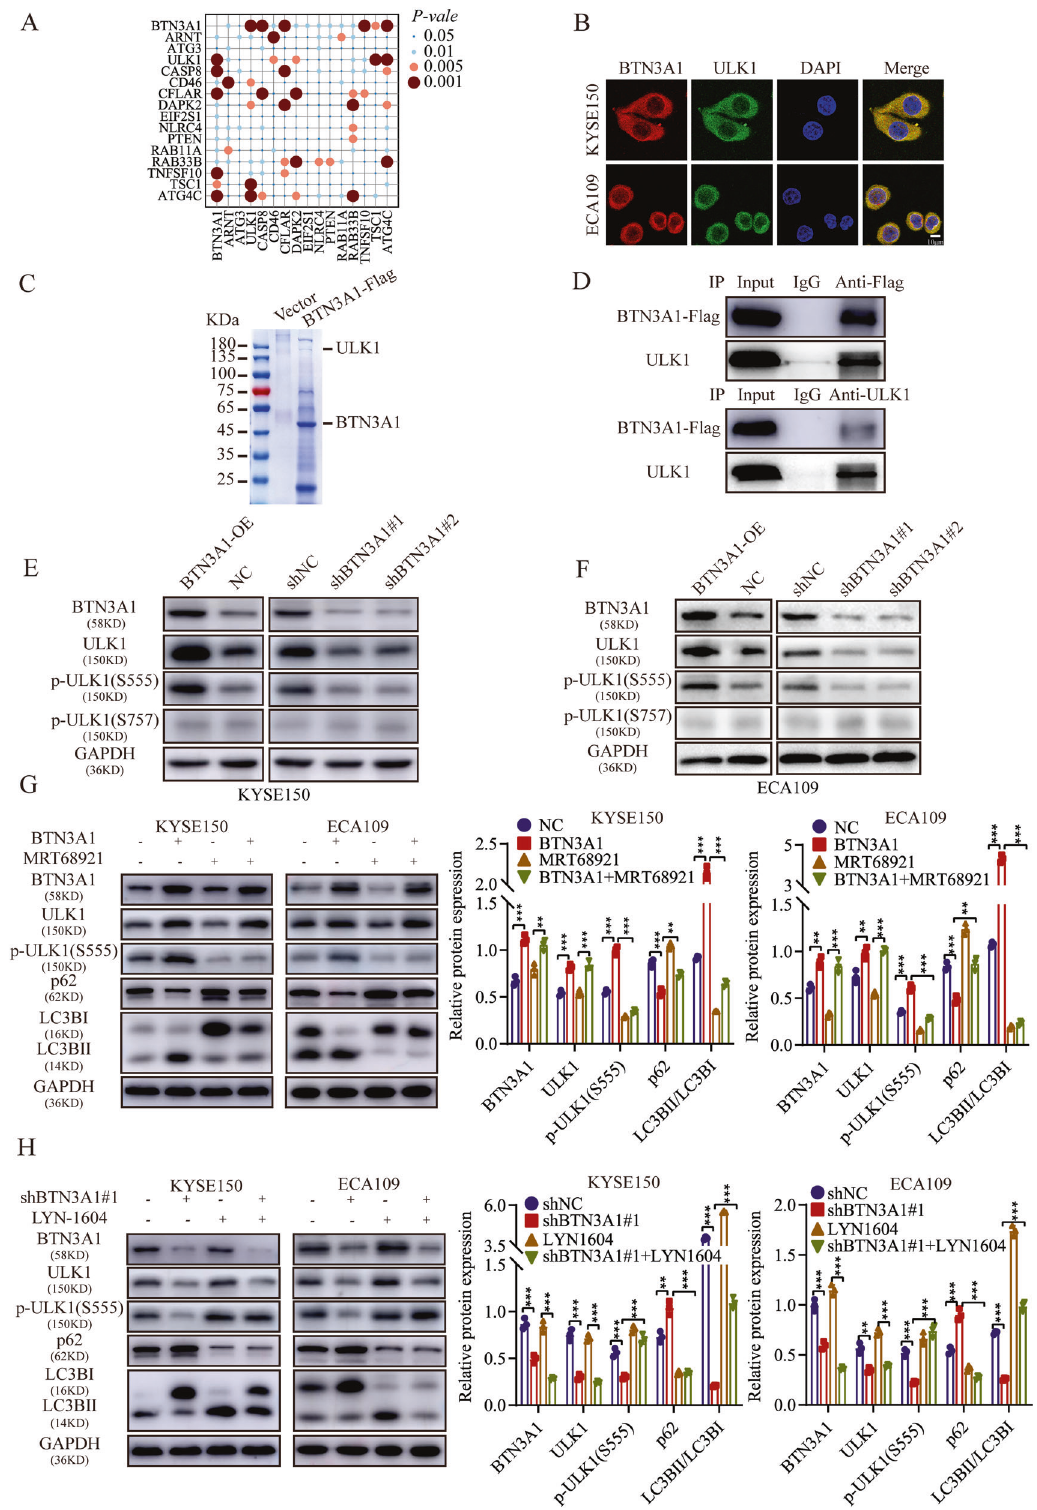
Immuno fl uorescence Cells were fi xed with 4% paraformaldehyde for 15 min at room temperature and then were permeabilized with 0.5% Triton-X100 for 20 min. After blocking with 5% BSA for an hour, the cells were incubated